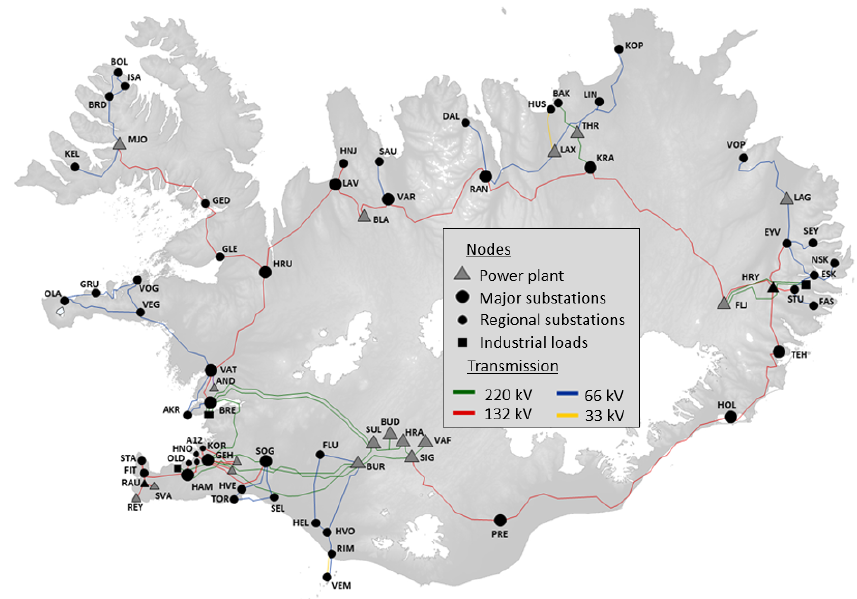
Figure 1. The Icelandic power system, with two 220 kV regions connected by a 132 kV